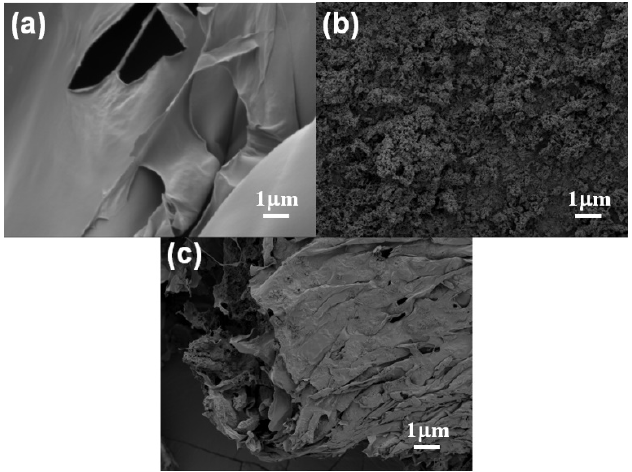
Figure 4. Scanning electron microscopy (SEM) images of xerogels and the dried sample obtained from freeze-drying method: ( a ) NaPPDT xerogel prepared from the corresponding NaPPDT 1.0 wt% hydrogel, ( b ) dried sample of 1.0 wt% PAPA aq., ( c ) NaPPDT / PAPA composite xerogel pre- pared from the corresponding NaPPDT/PAPA 1/1 ( w / w ) composite hydrogel.